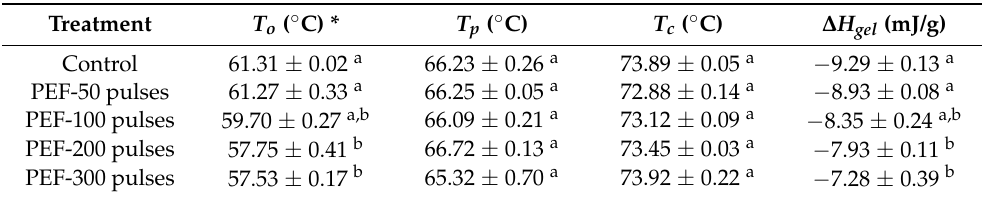
Table 4. Differential scanning calorimetry (DSC) measurements for gelatinization properties of glutinous rice flour with or without PEF treatment #